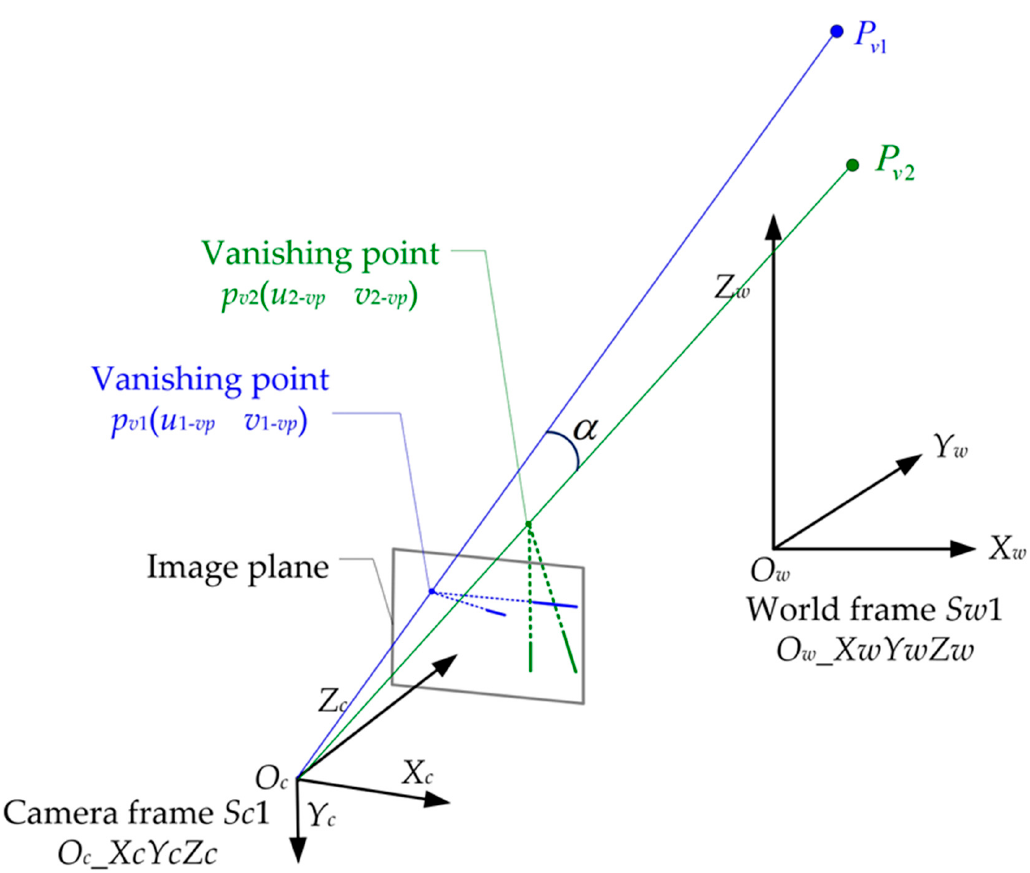
Figure 2. Two vanishing points were used for focal length estimation. In Figure 2, α is not only the angle between the lines O c P v 1 and O c P v 2 in the world frame S w 1 but is also the angle between the lines O c p v 1 and O c p v 2 in the camera frame S c 1 . The expressions of the unit direction vectors of the lines O c P v 1 and O c P v 2 in the